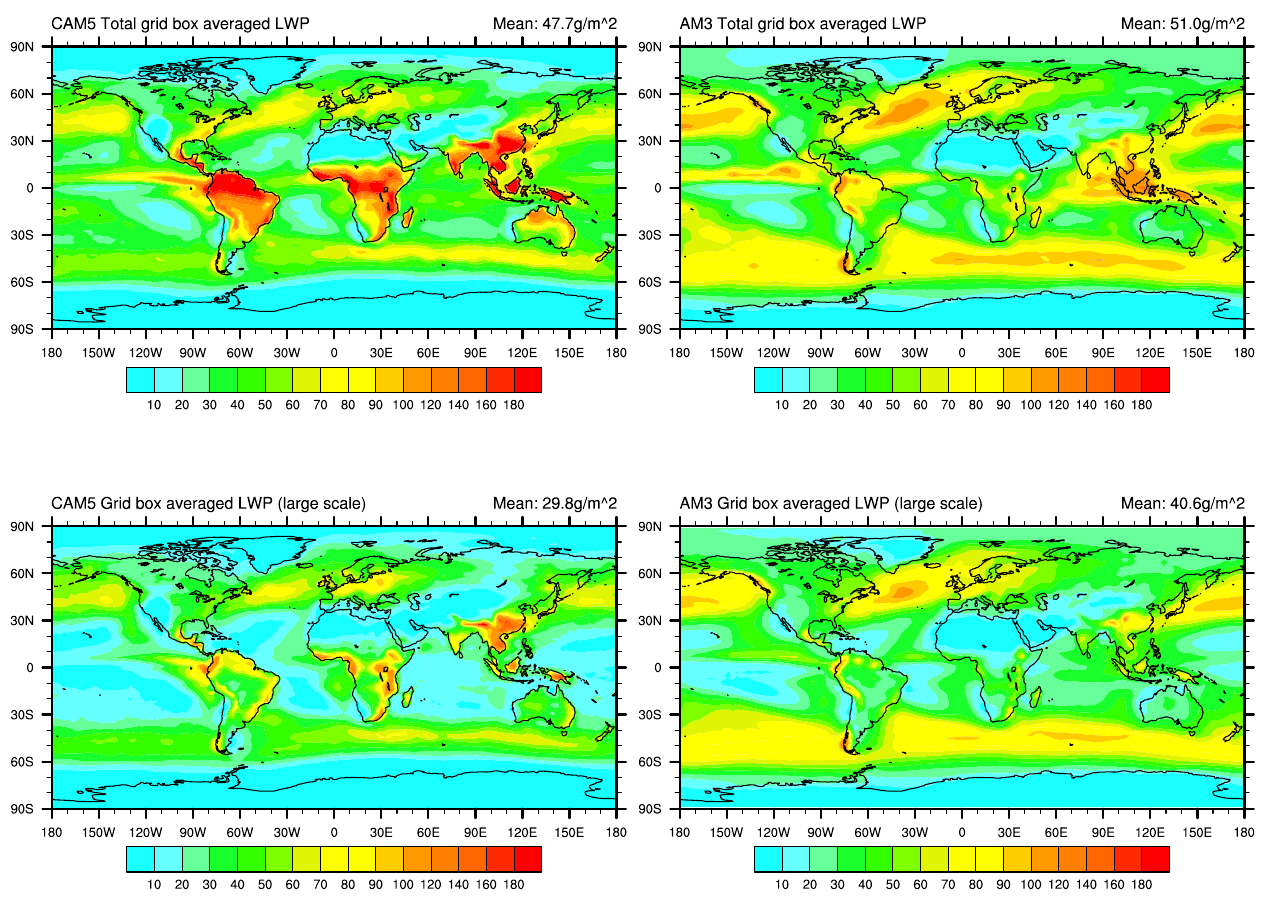
Fig. 5. Annual average total grid box averaged liquid water path (LWP) (top) and the large scale LWP (bottom) from CAM5 (left) and AM3 (right). Table 3. Summary of Global Burdens (Tg) (in bold) and Lifetimes (days) (in